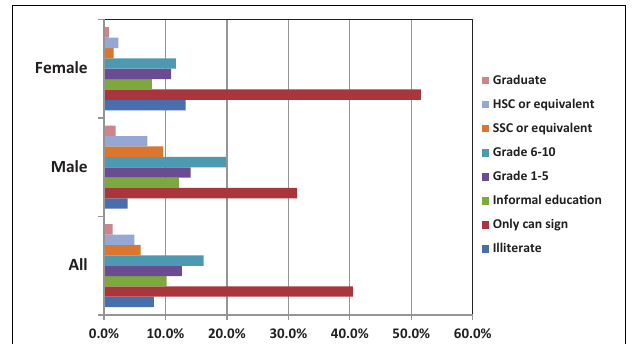
FIGURE 5 | Proportion of the respondents with respect to educational status.